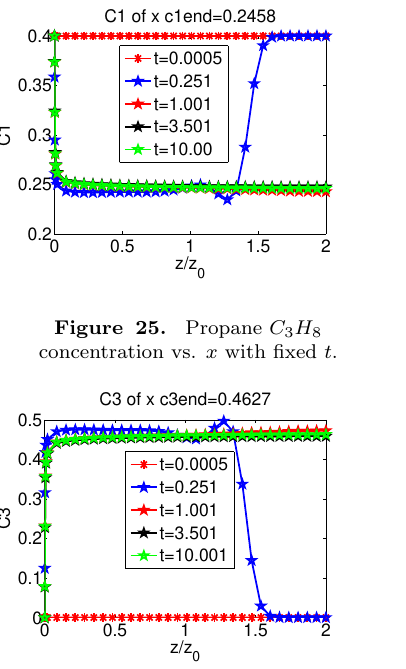
Figure 28. H 2 O concentration vs. x with fixed t